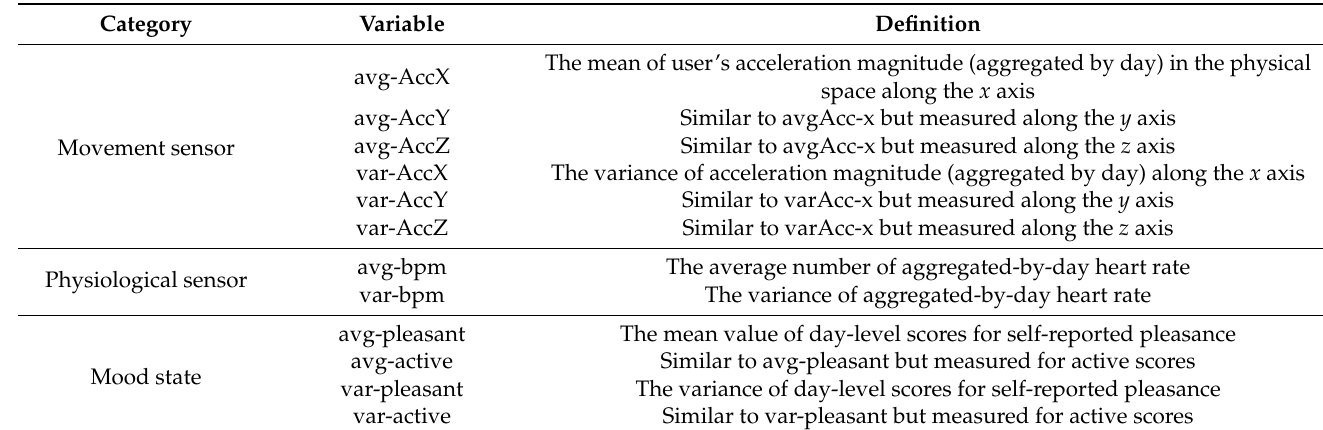
Table 2. Explanation of Happimeter